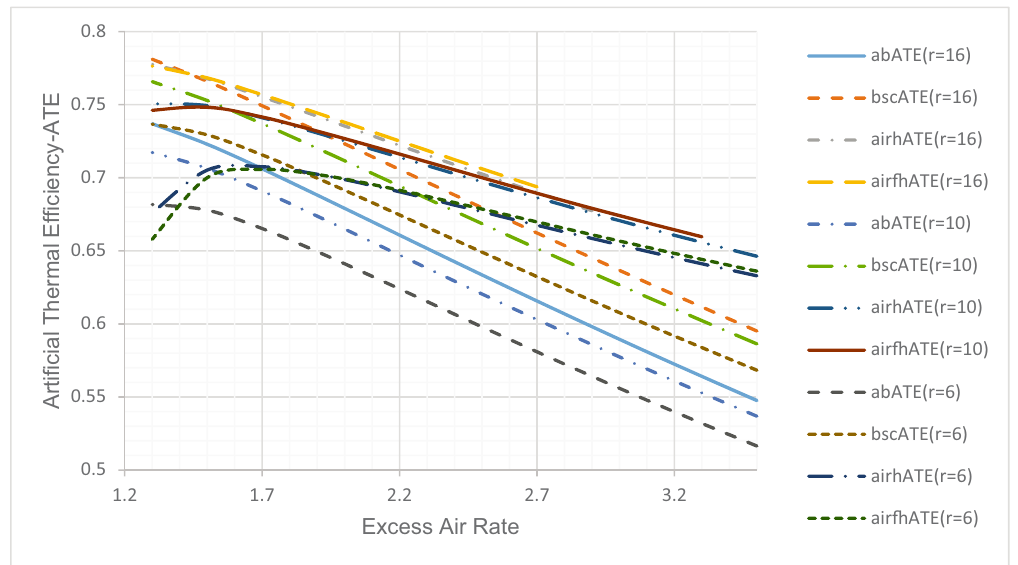
Figure 9: Variation of arti fi cial thermal e ffi ciency with excess air coe ffi cient at di ff erent compressor compression ratios for basic ( bsc ) , absorption cooling ( ab ) , air ( airh ) , and air fuel ( airfh ) heating cogeneration cycles ( m fuel = 1.64 kg/h, η isC = η isT = 0.86, r = 10, T recout = 850 K, T = 485.57 K, and T = 426 K ) steam Exh